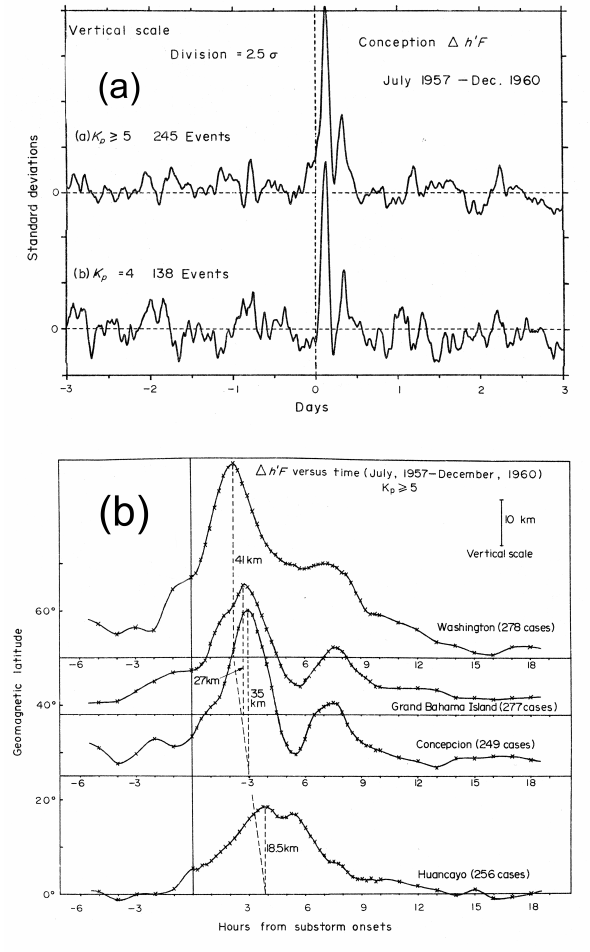
Fig. 1. Reproductions of average 1h 0 F levels relative to sub- storm onsets from (a) Fig. 3 of Bowman (1978) for Conception and (b) Fig. 2 of Bowman (1978) for a range of stations as LS-TIDs propagate towards the equator.